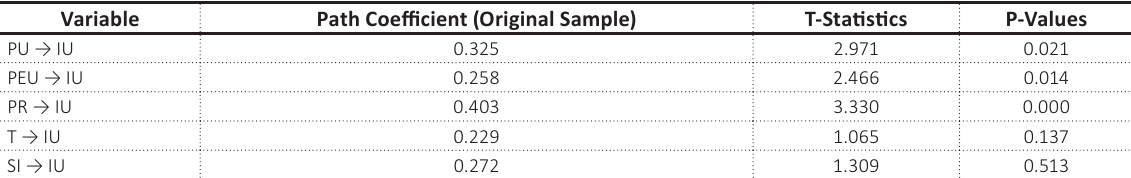
Table 5. PLS path algorithm and